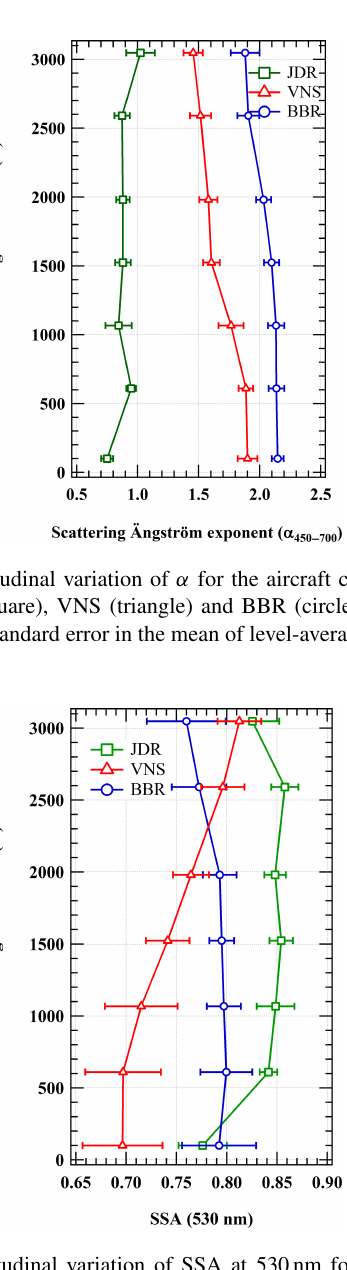
Figure 5. Altitudinal variation of SSA at 530nm for the aircraft campaign stations: JDR (square), VNS (triangle) and BBR (circle). Error bars represent the standard errors.